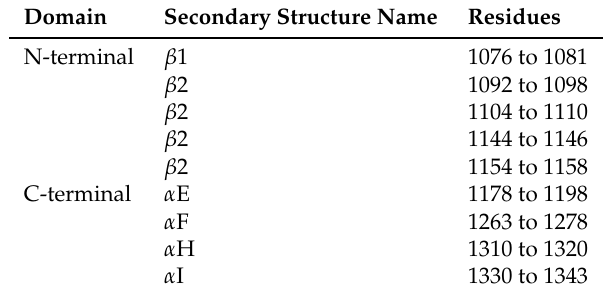
Table 4. List of the secondary structure elements used for aligning all the conformers.